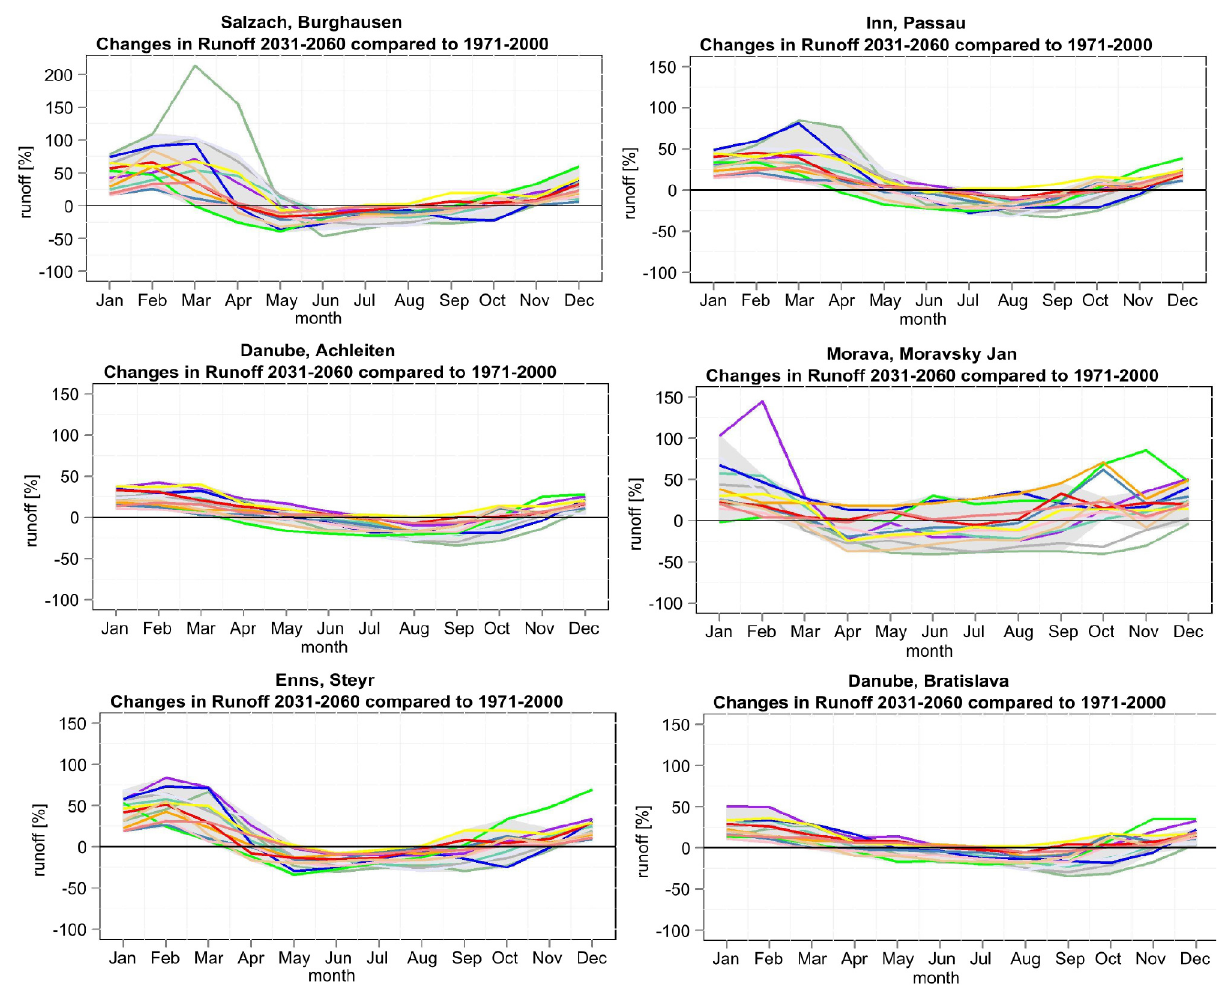
Figure 10. Changes (%) in the mean runoff seasonality between the reference period 1971–2000 and the near future scenario period 2031–2060 for selected stations in the Upper Danube River catchment. The grey ribbon comprises the range of results without